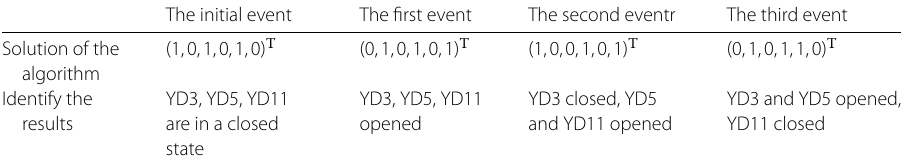
Table 5 Equipment state recognition